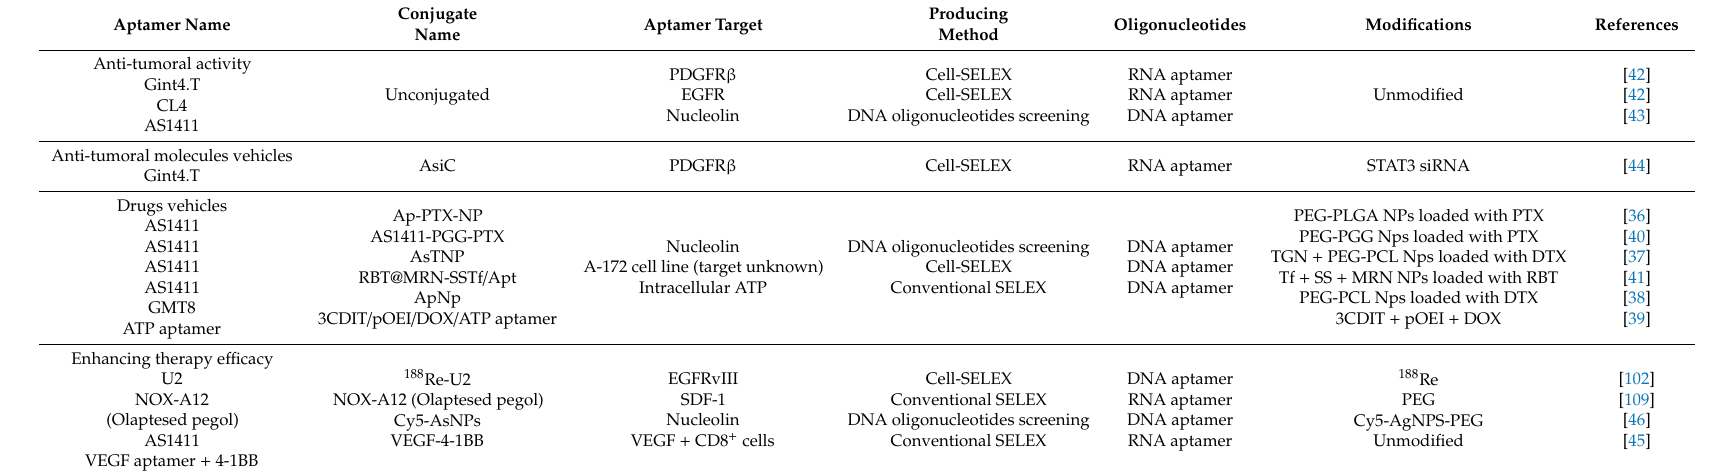
Table 1. The characteristics of aptamers used to treat GBM in